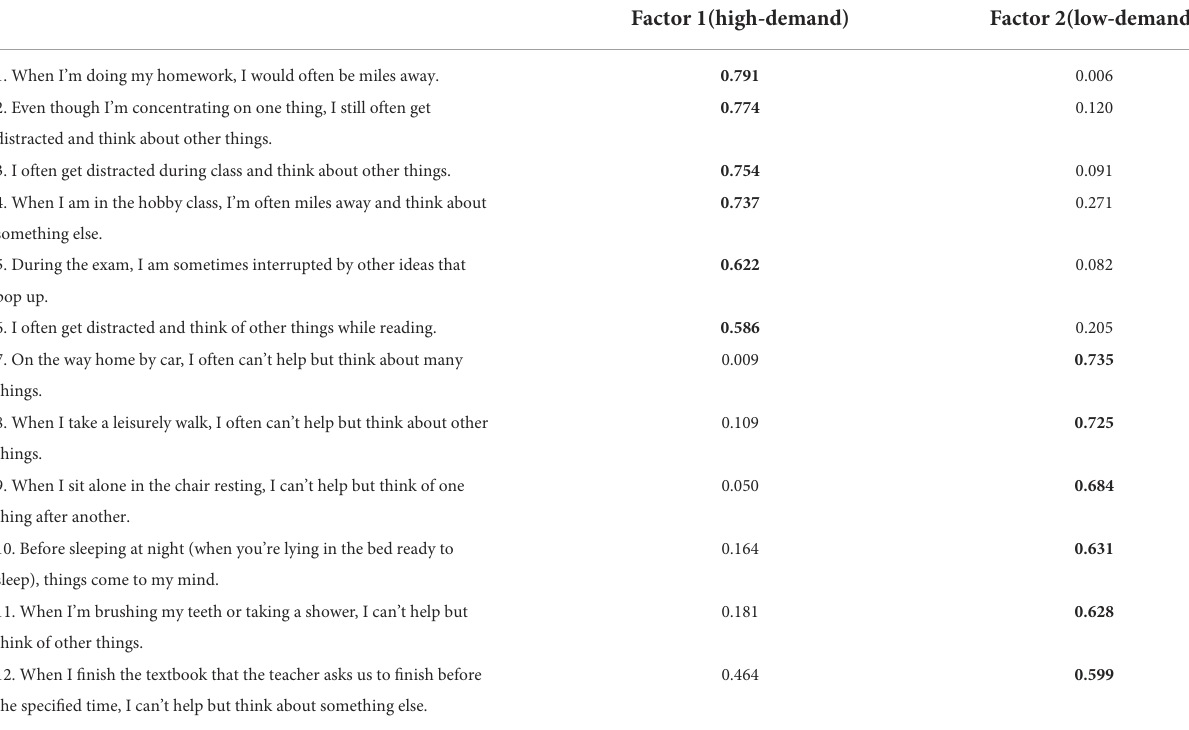
TABLE 3 Factor loadings of the CMWS-C.